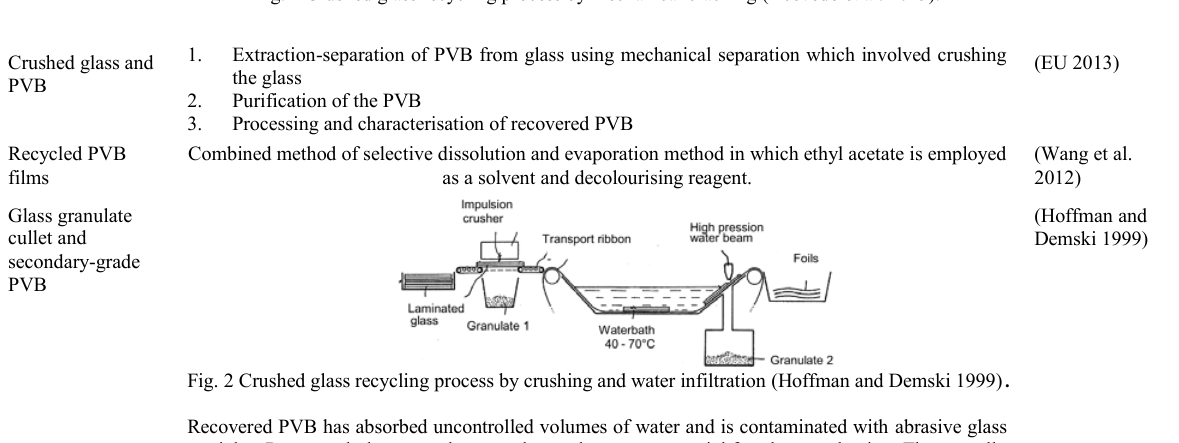
Fig. 1 Crushed glass recycling process by mechanical cracking (Acevedo et al. 2013).